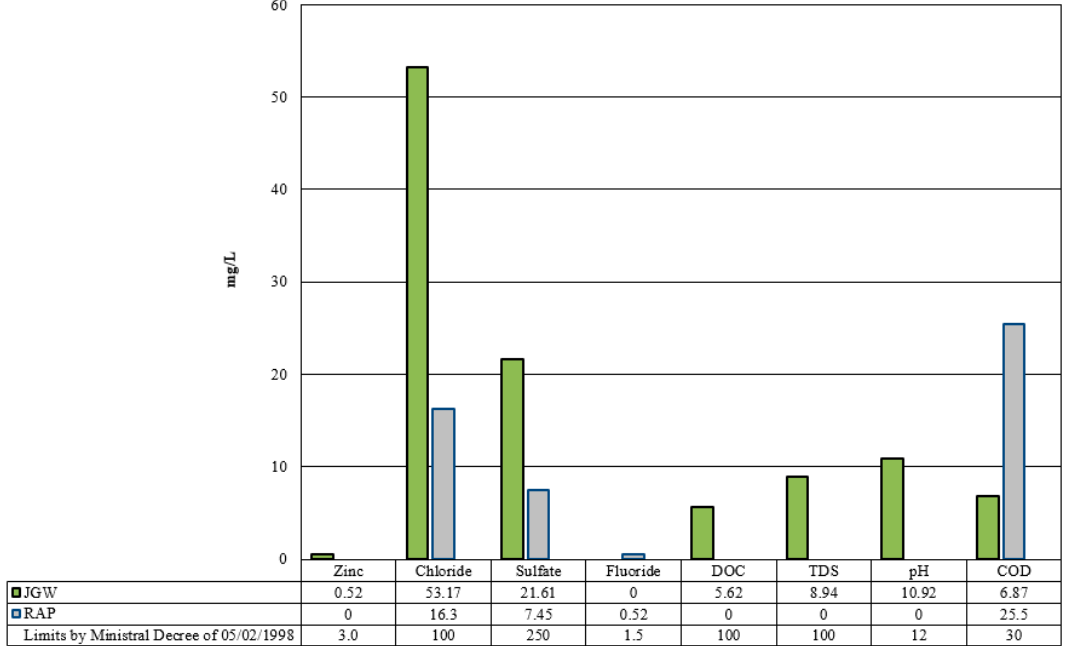
Figure 5. Leaching test results.